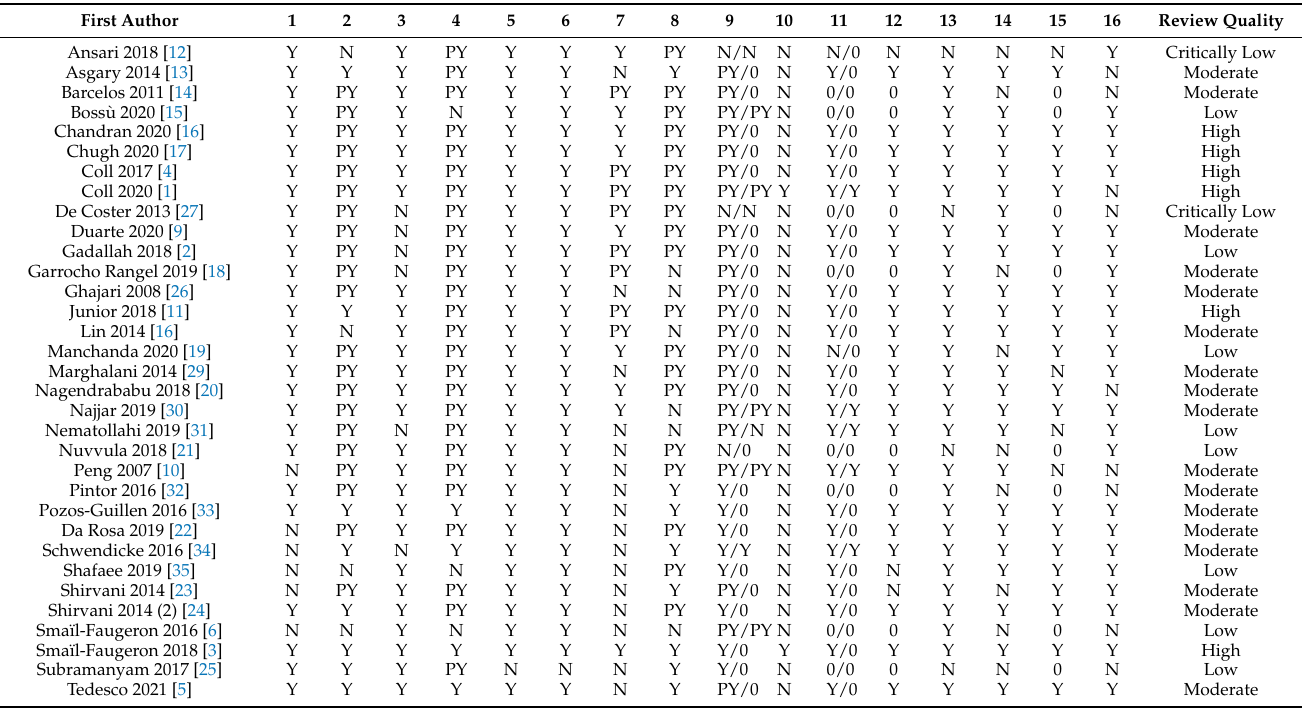
Table 2. Results of the methodological quality assessment via